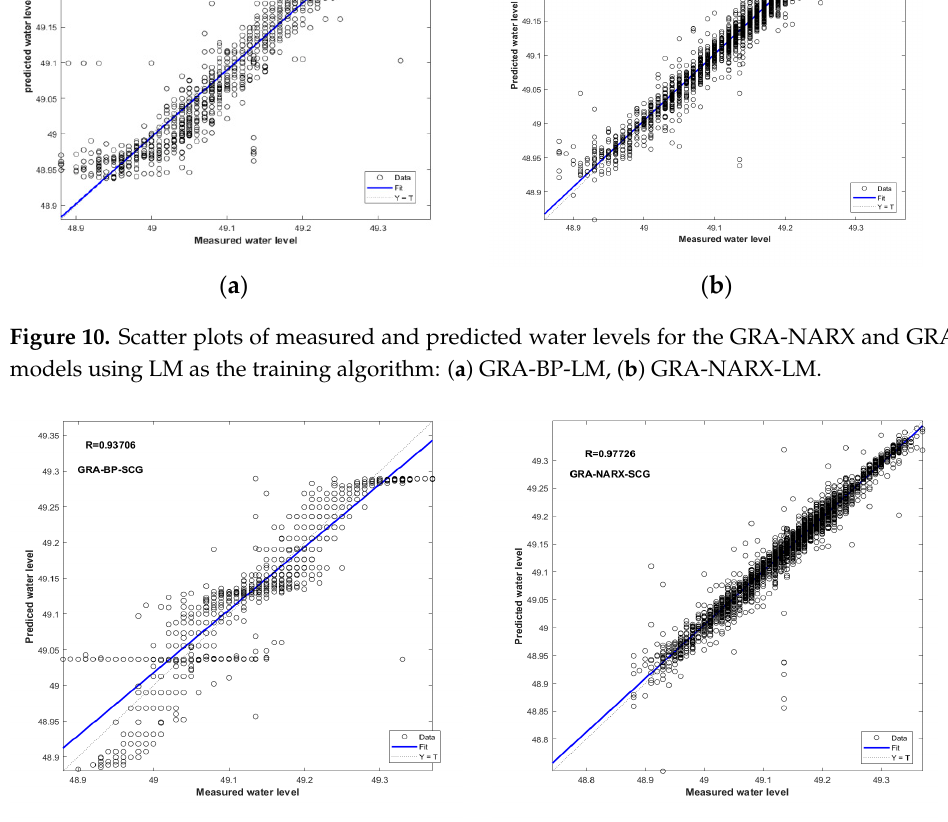
training algorithm, the MSE is 2.9929 × 10 − 4 , 7.1824 × 10 − 4 , and4.5796 × 10 − 4 with MAE of